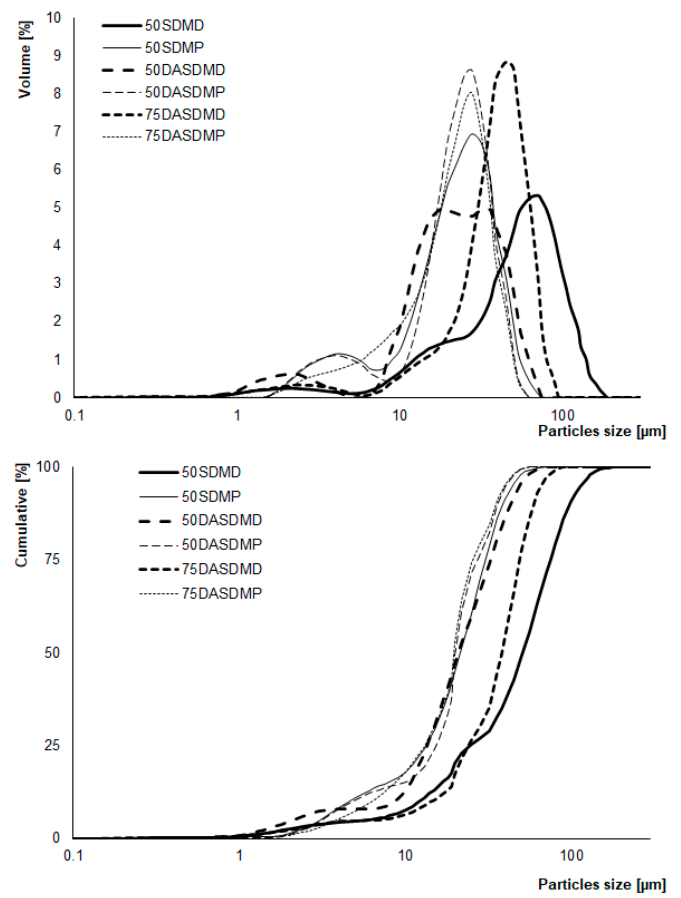
Figure 3. Particle size distribution and cumulated particle size distribution of buckwheat honey powders containing 50 and 75% honey solids obtained with maltodextrin (MD) or milk powder (MP) as carriers by conventional spray drying (SD) and dehumidified-air-assisted spray drying (DASD).